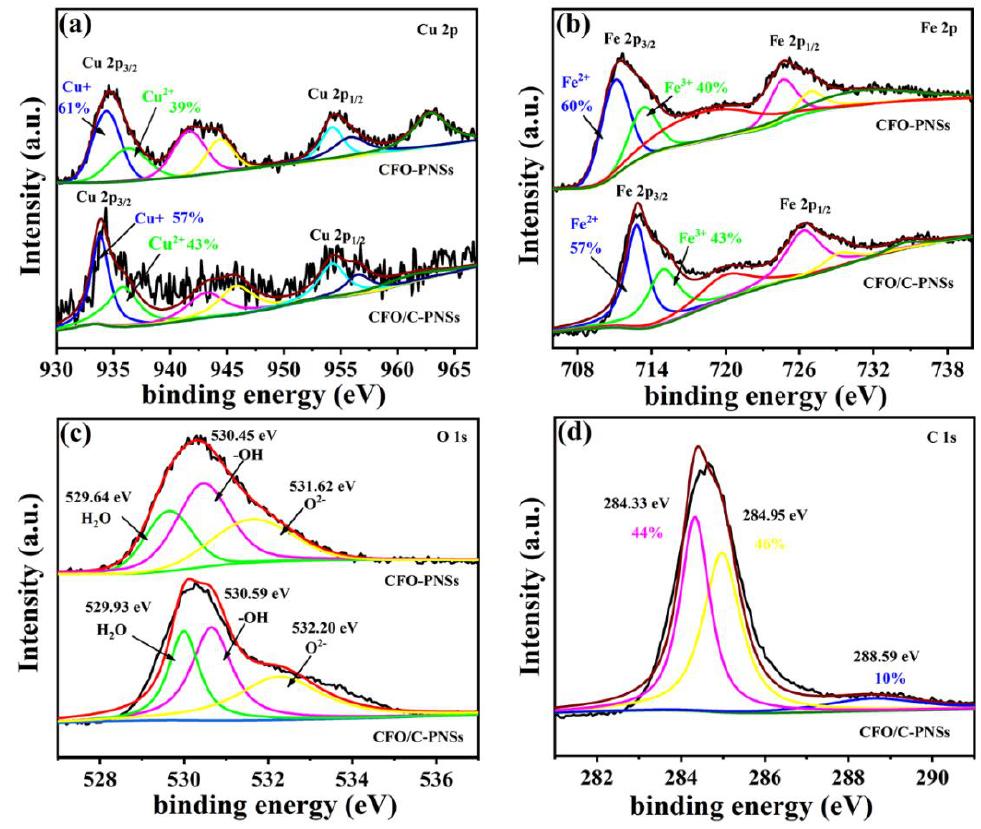
Figure 6. XPS spectra of CFO/C-PNS and CFO-PNS samples: ( a ) Cu 2p, ( b ) Fe 2p, ( c ) O 1s, ( d ) C 1s.